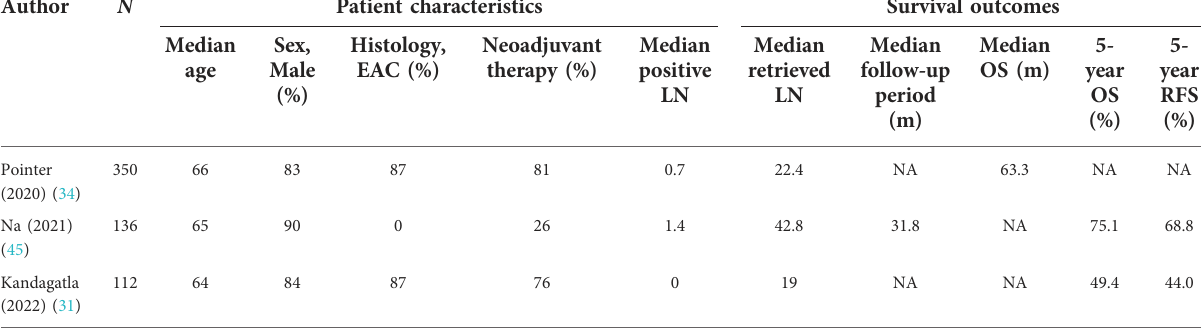
TABLE 2 Patient characteristics and long-term outcomes of studies on robot-assisted Ivor Lewis esophagectomy.